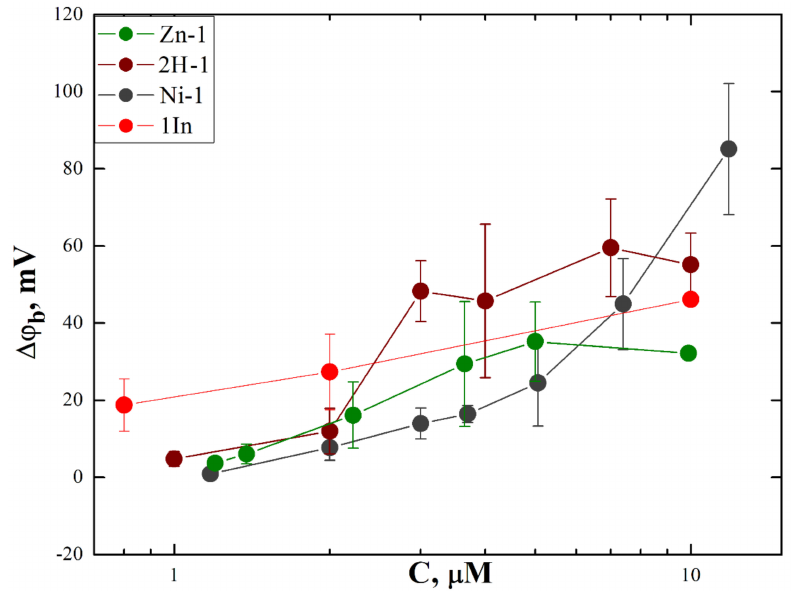
Figure 4. The change in the boundary potential difference across the BLM due to adsorption of porphyrins as a function of their concentration in the solution. Measurements were performed in buffer solutions containing 20 mM KCl, 2 mM HEPES, pH 7.0. Data for In(III) complex of β -imidazolium-substituted porphyrin (1In, red) were taken from [8] for the